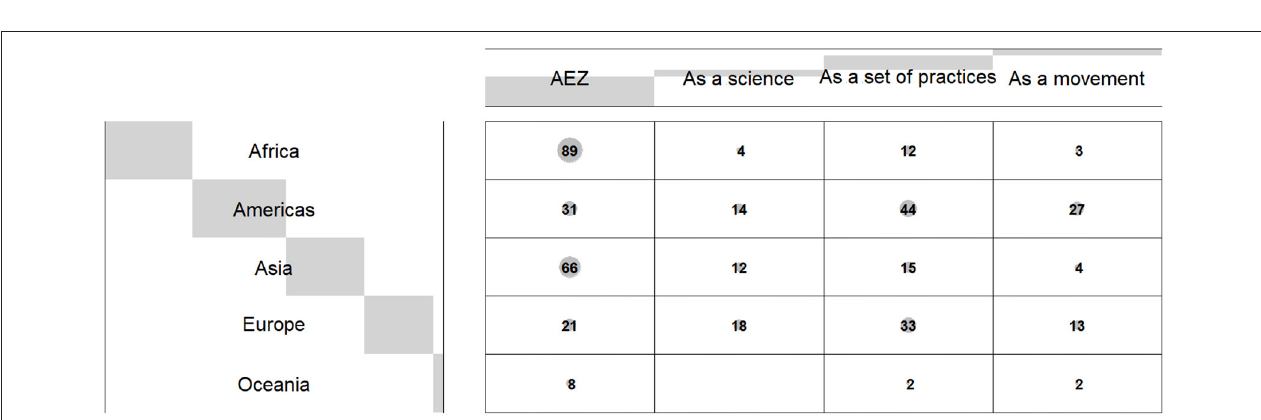
FIGURE 2 | Regional location of case studies and the percentage of the agroecological type studied in each region. Distribution: North America ( n = 23); Central America ( n = 20); South America ( n = 52); Europe ( n = 68); Western Africa ( n = 37); Eastern Africa ( n = 54); Southern Asia ( n = 42); South-eastern Asia ( n = 27).